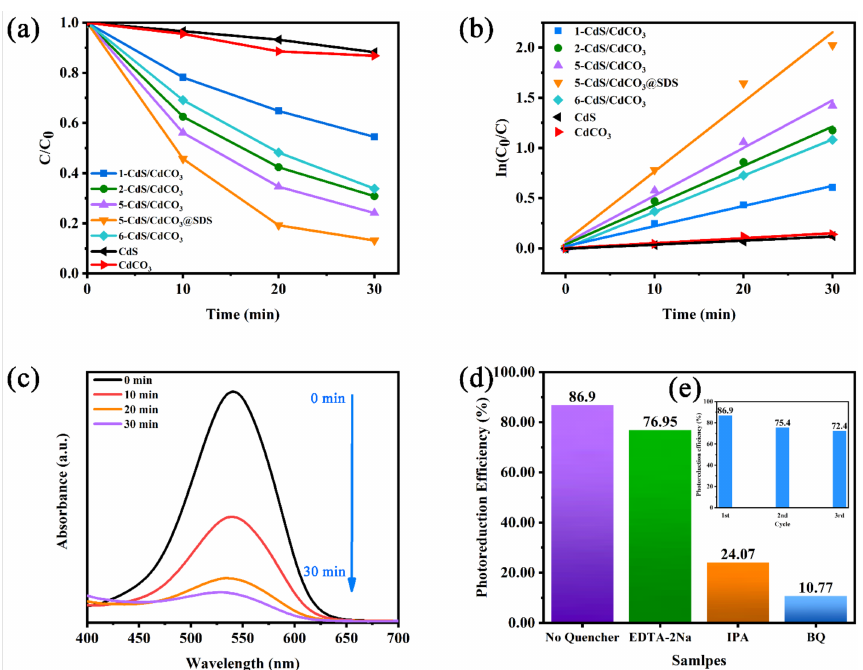
Figure 4. The change in Cr(VI) solution concentration with illumination on different samples ( a ), the corresponding kinetics of Cr(VI) degradation ( b ), the photocatalytic performance of 5- CdS/CdCO 3 @SDS ( c ), the effect of scavengers on the Cr(VI) degradation ( d ) and the cycling runs of -CdS/CdCO 3 @SDS ( e ).